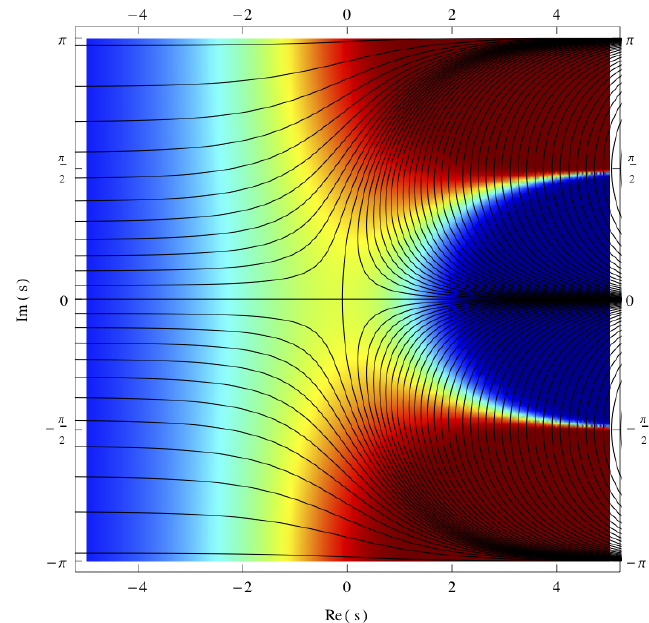
Figure 14: The steepest descent contours (B.3) at λ = 1.1, with log c ranging from roughly − 8 to 8. The picture is 2 π -periodic along the imaginary axis, so we let Im ( s ) range from − π to π . Note the crossing of paths at the saddle point s = − log λ . Background colors reflect the norm of the function exp [ N ( s − λ e s )] : blue means it approaches zero, while red means it blows up. Accordingly, all stationary phase paths that escape to minus real infinity are steepest descent curves when traced from right to left, while those trapped in the region Re ( s ) ≥ − log λ can be steepest descent or steepest ascent when traced from left to right, respectively depending on whether they end up in a blue zone or a red